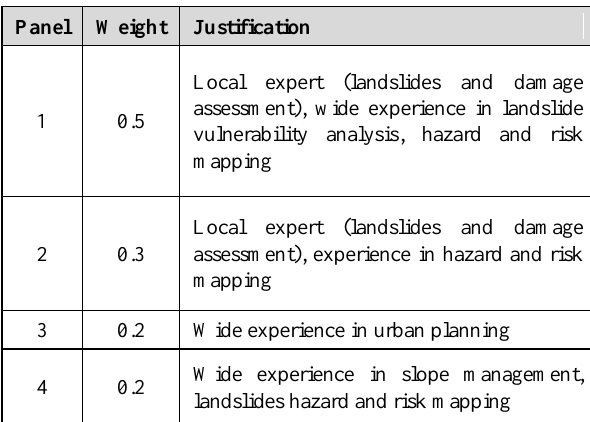
Table 3. Weight value for each panel